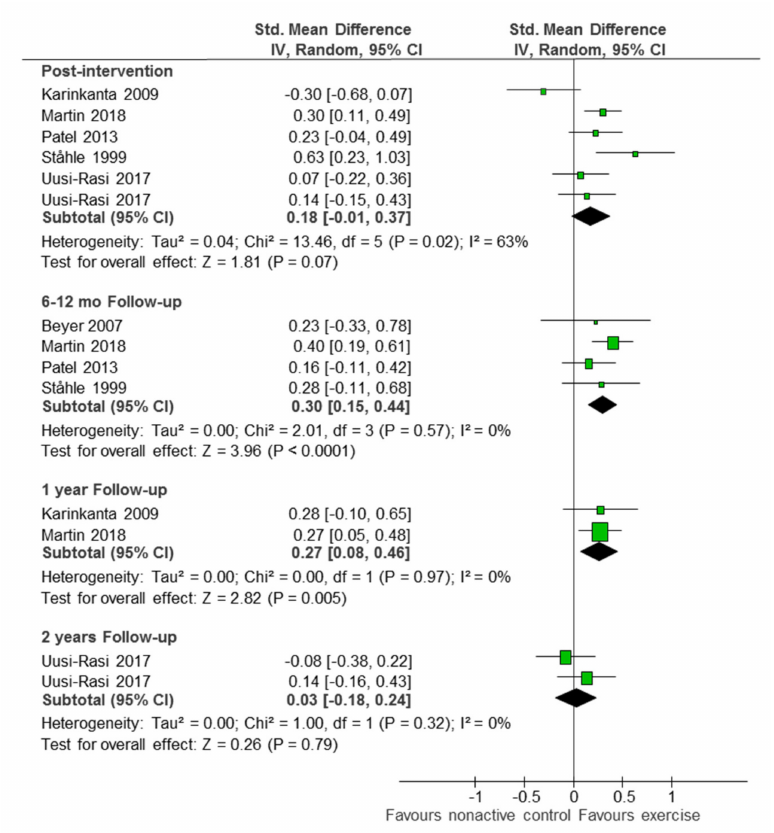
Figure 3. Exercise-based intervention versus non-active control (self-reported PA). Abbreviations: Std. Mean Di ff erence: standardized mean di ff erence; IV, Random: a random-e ff ects meta-analysis is applied, with weights based on inverse variances; 95% CI: 95% confidence interval; df: degrees of freedom; Tau 2 and I 2 : heterogeneity statistics; Chi 2 : the chi-squared test value; Z: Z-value for test of the overall e ff ect; P: p